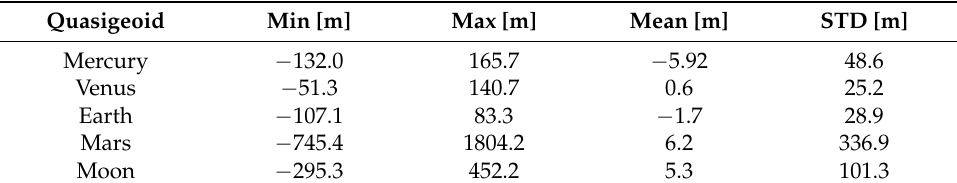
Table 2. Statistics of the quasigeoid heights on Mercury, Venus, Earth, Mars and the Moon.